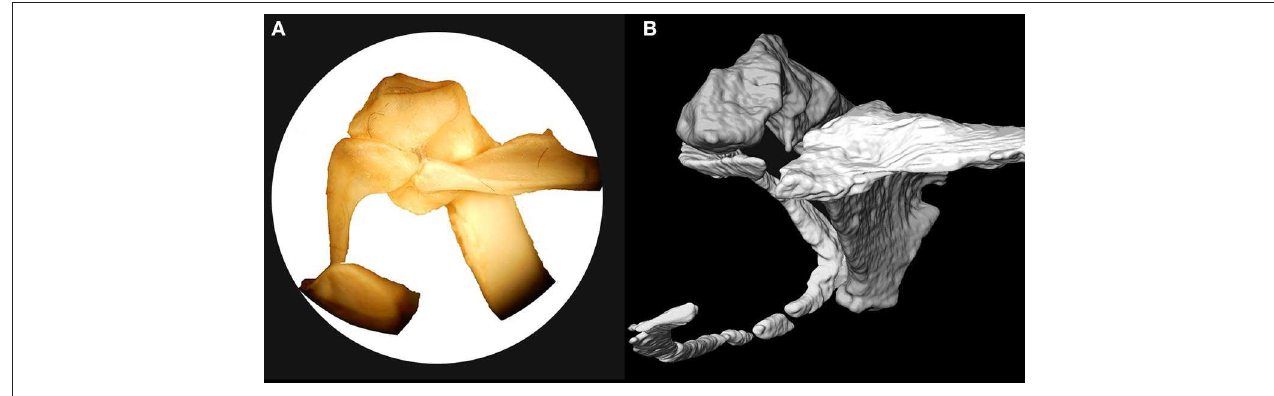
FIGURE 5 | Detailed articular anatomy of coracoid-scapula-furcula of Pterocles bicinctus (USNM 429081) (A) and Linxiavis inaquosus (B)